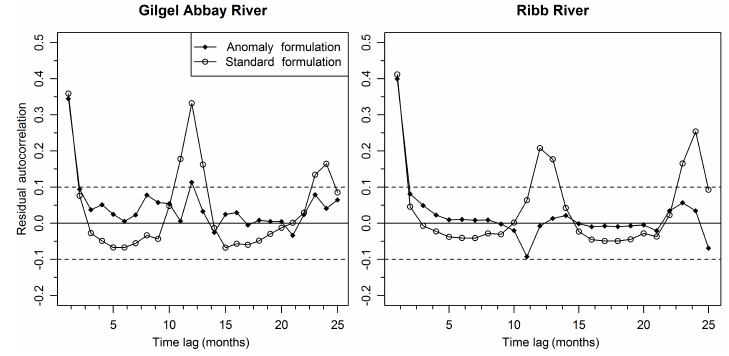
Figure 2. Autocorrelation in model residuals for the Gilgel Abbay and Ribb rivers.